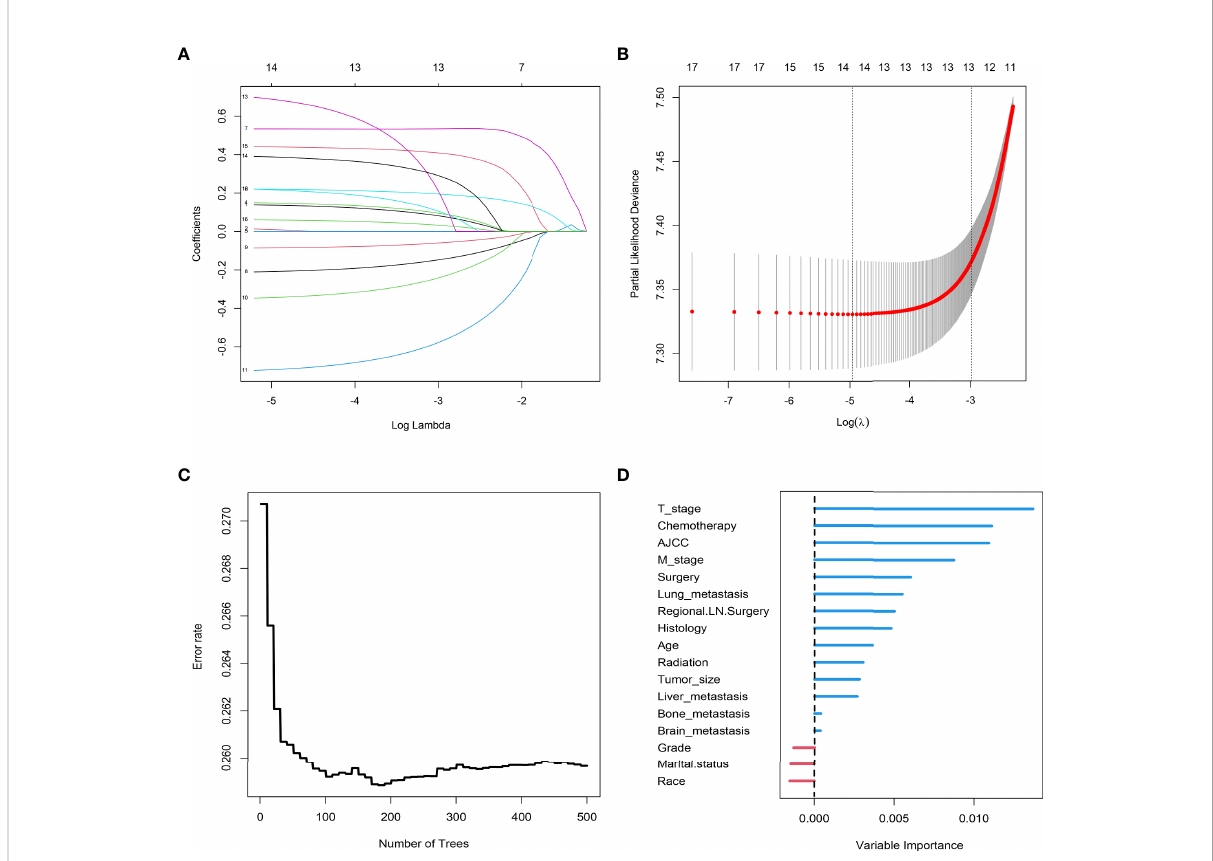
FIGURE 5 LASSO regression analysis was used to screen out factors related to the prognosis of patients with CC with LNM: (A) LASSO coef fi cients (B) Selection of the tuning parameter ( l ). Random forest analysis, (C) forest tree and (D) Importance score.